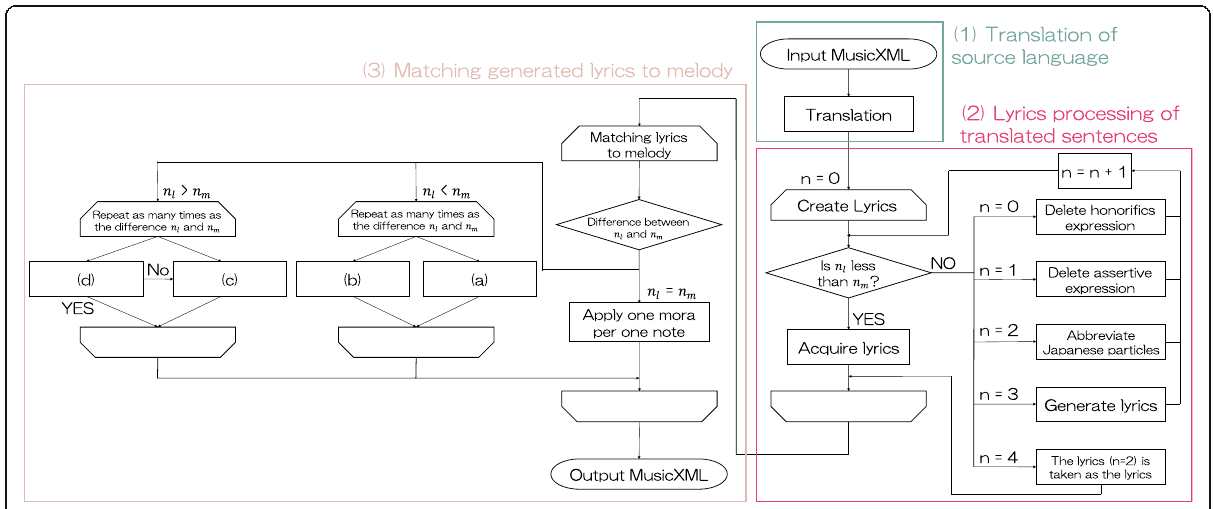
Fig. 2 Processing procedure of lyrics transcreation (arranged from ref.